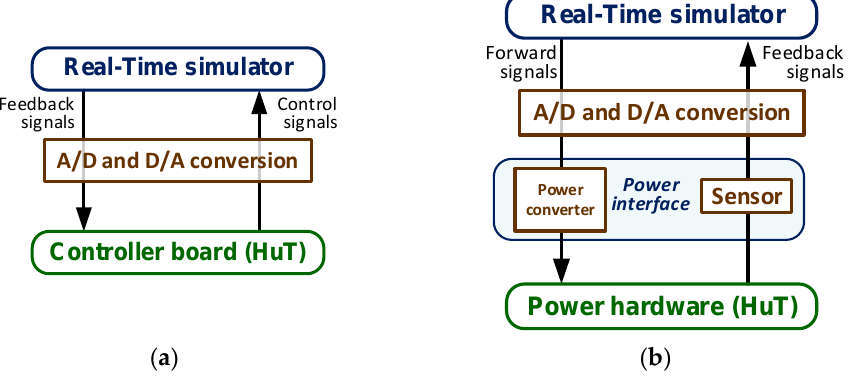
Figure 1. Basic HIL simulation: ( a ) CHIL and ( b ) PHIL.